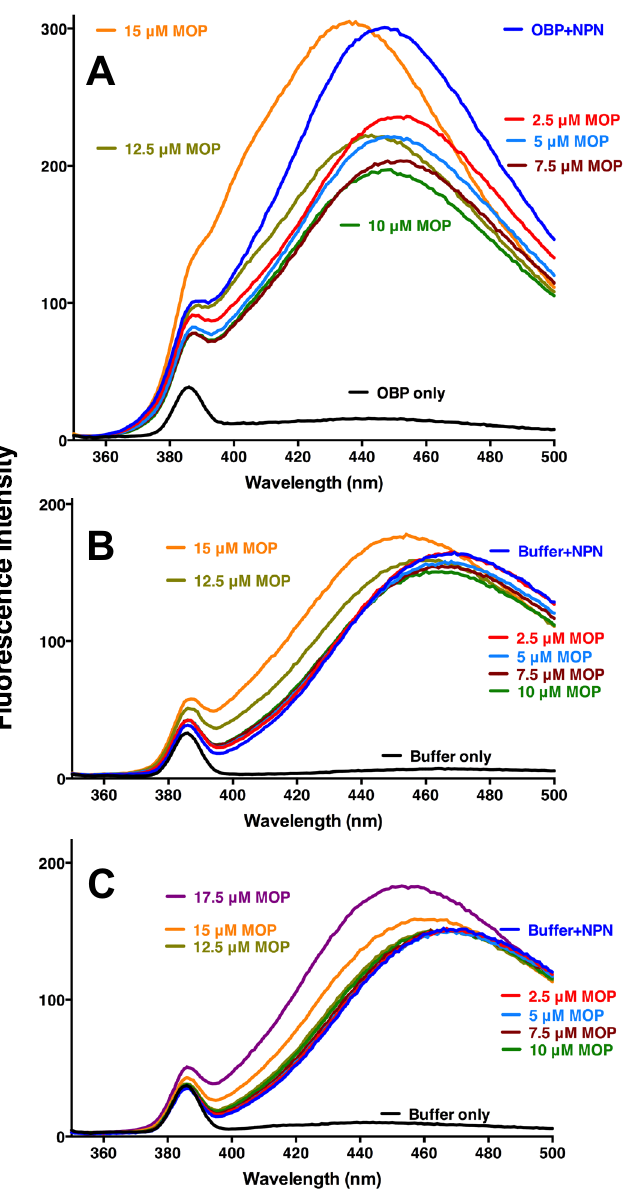
Figure 5. Titration of NPN fluorescence emission with MOP. ( A ) NPN (2.5 µM) was added to a solution of AaegOBP1 (0.35 µM) in ammonium acetate buffer, pH 7. NPN (2.5 µM) was added to ammonium acetate buffer, ( B ) pH 7 or ( C ) pH